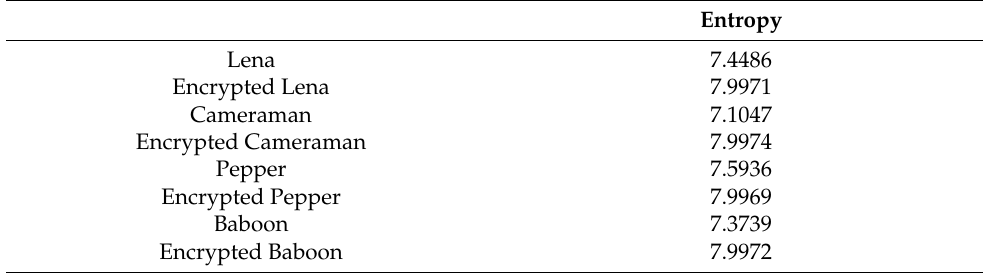
Table 5. The information entropy of the variant